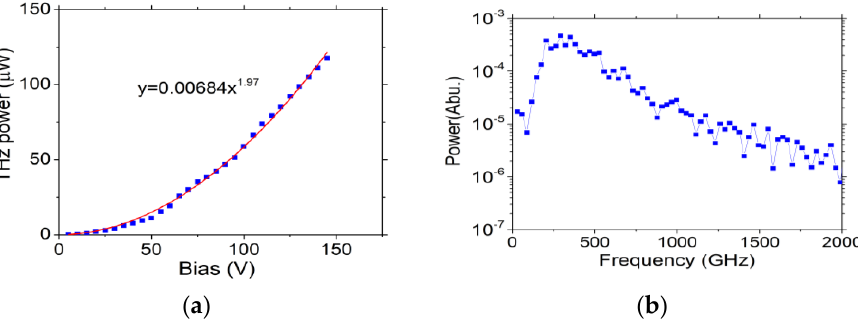
Figure 3. ( a ) Terahertz (THz) power vs. bias voltage at a laser power of 65 mW. ( b ) Power spectrum obtained from auto-correlation measurement.